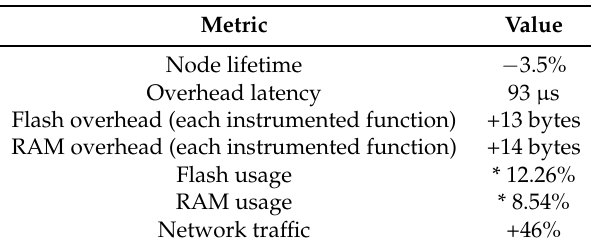
Table 5. Evaluation results